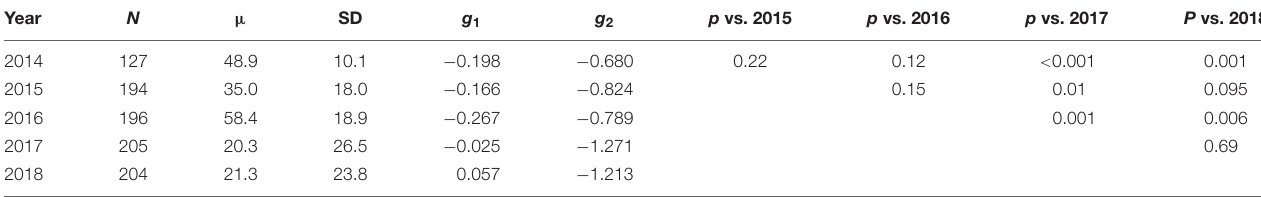
TABLE 1 | Distribution parameters of the population size-frequency distributions.